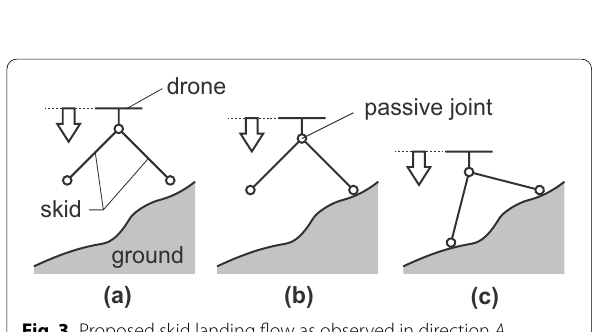
Fig. 3 Proposed skid landing flow as observed in direction A